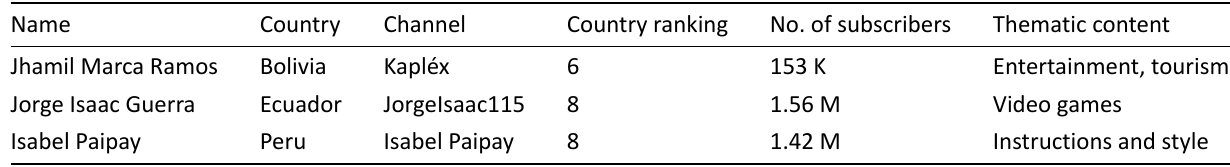
Table 3. Profile of the YouTubers